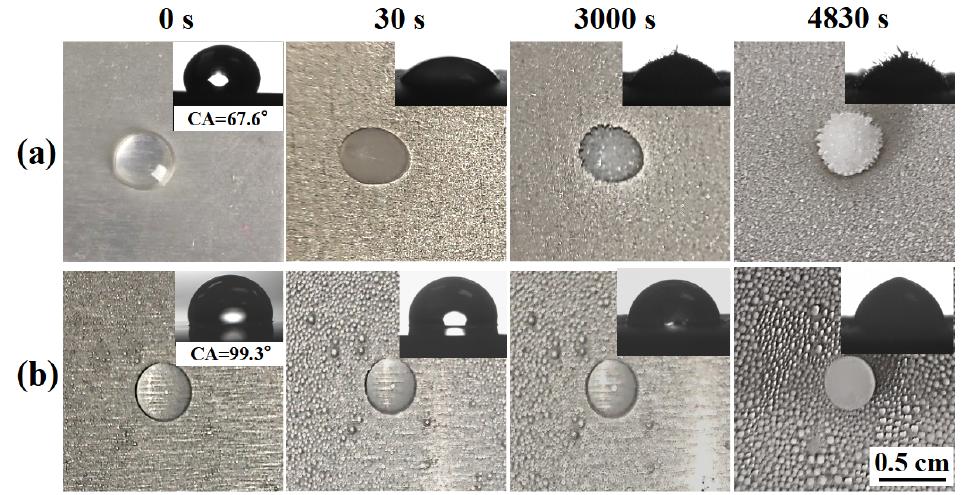
Figure 5. The freezing process of water drops on a bare aluminum surface ( a ) and SLIPS ( b ) at − 10 °C; the insets show the contact angle of bare aluminum surfaces and SLIPS.